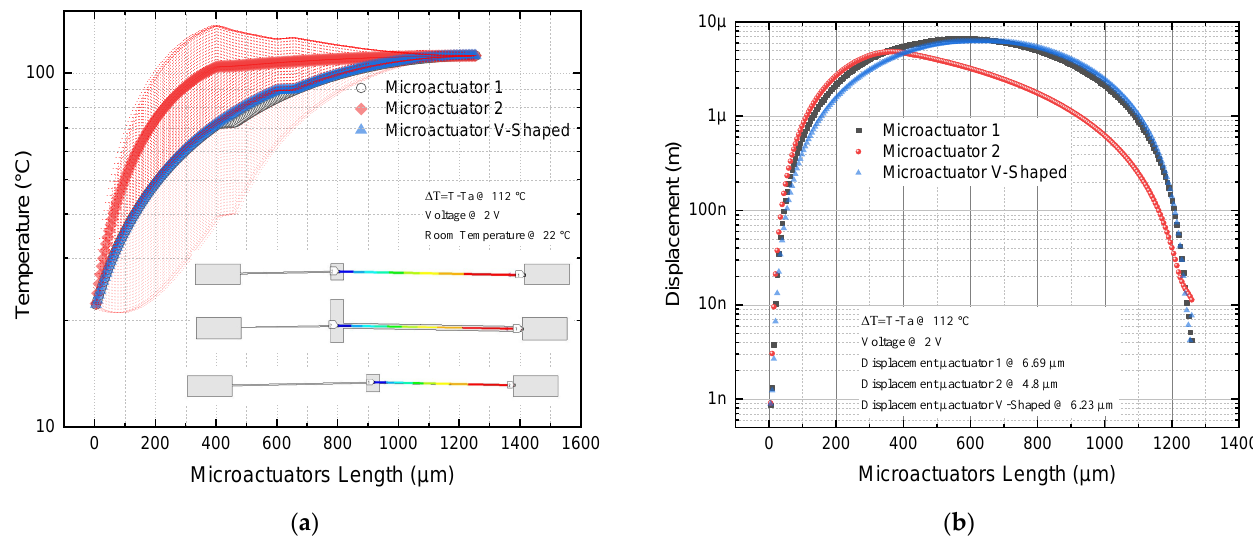
Figure 7. ( a ) Temperature and ( b ) displacement of microactuators 1, 2, and V-shaped.